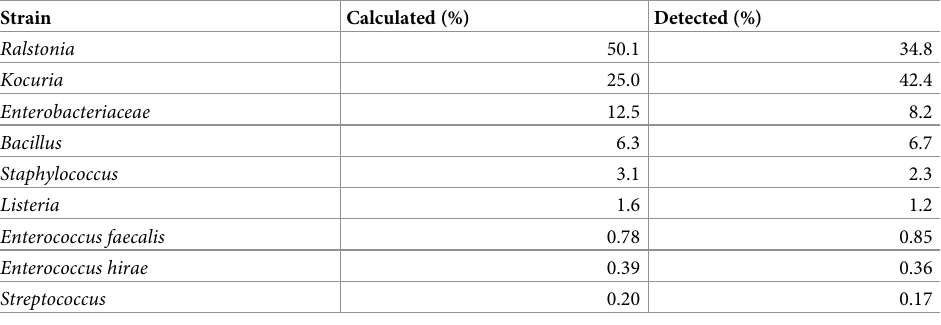
Table 2. Detection of the relative abundances in samples of mixed bacteria with different abundance ratios.